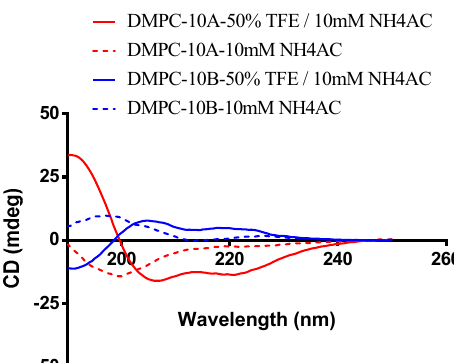
Figure 1. Secondary structure analysis of DMPC-10A and DMPC-10B; 50- µ M peptides analyzed by treatment with 10 mM NH 4 AC and 50% trifluoroethanol (TFE) / 10 mM NH 4 AC. The spectra were averaged over three consecutive scans and the solvent circular dichroism (CD) signal was